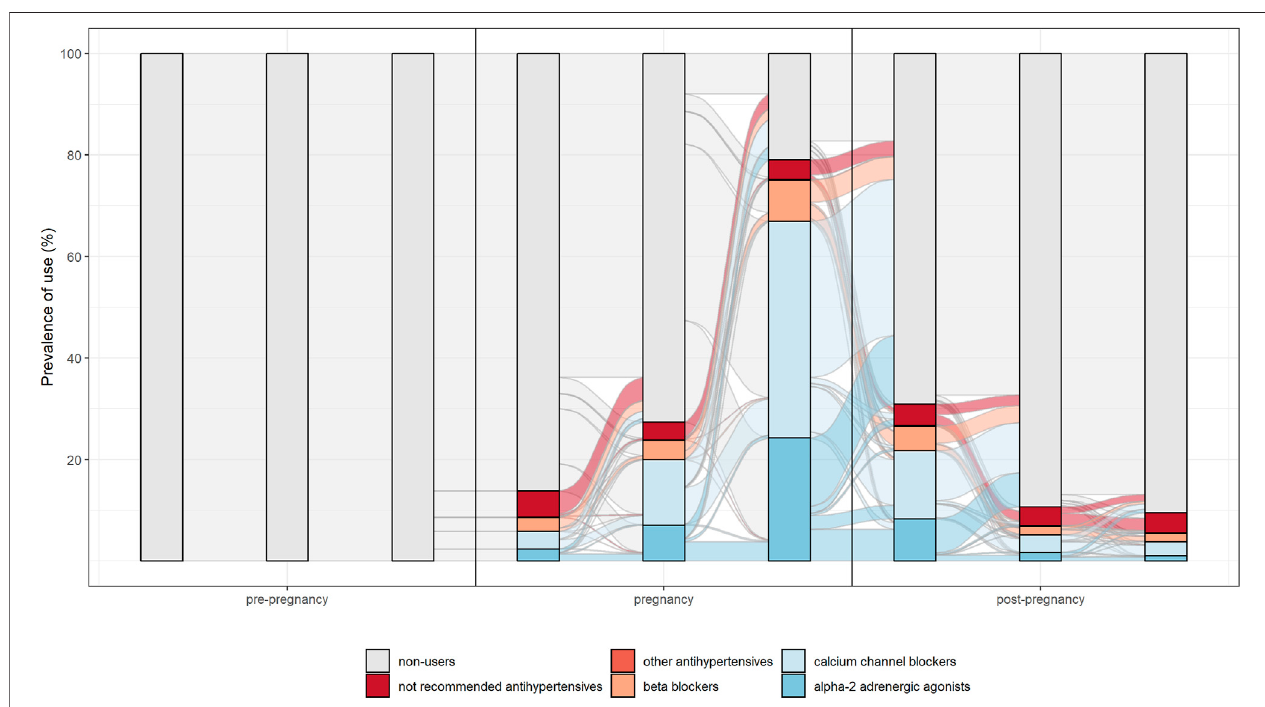
FIGURE 3 | Sankey diagram used to describe the pattern of drug use in different trimesters of pregnancy: the example of antihypertensive in women with incident use in pregnancy.